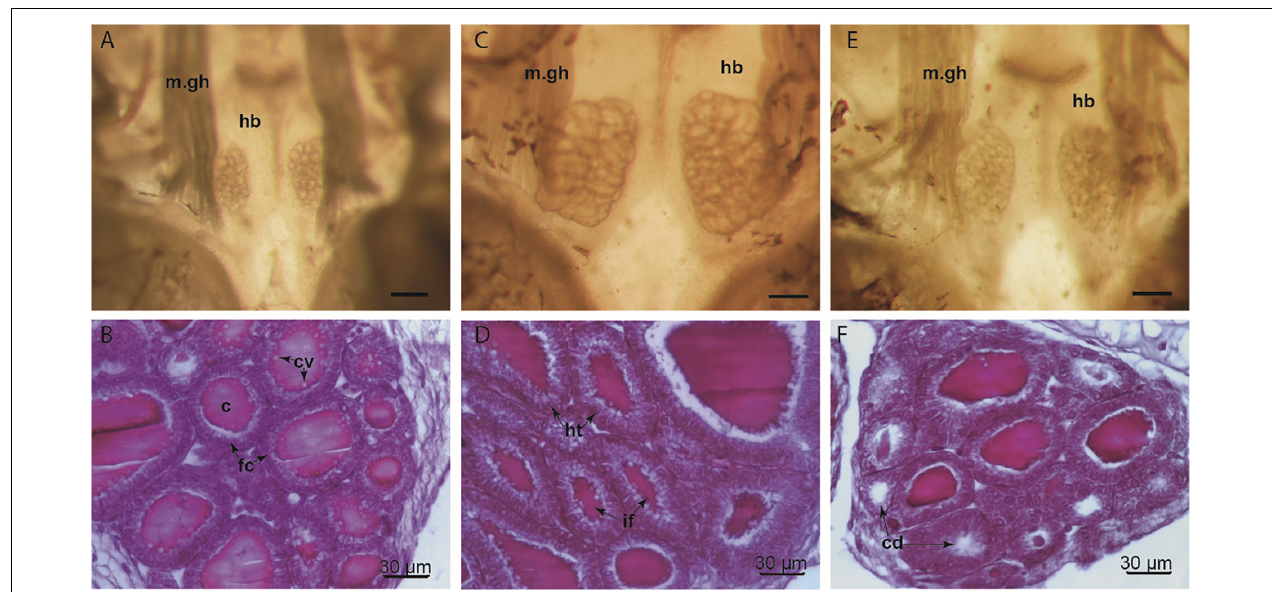
FIGURE 2 | Thyroid gland of Pleurodema borellii larvae (Gosner Stage 40, 31 days after hatching), macroscopic and microscopic images. (A,B) Control tadpoles showed the typical follicular morphology of the normal thyroid gland, with cuboidal follicular cells and follicular colloid. (C,D) Specimens from methimazole early exposure exhibited an overall glandular hypertrophy. The histology revealed an evident follicular cell hypertrophy and irregular follicular morphology. (E,F) Specimens from thyroxine early exposure have thyroid glands with follicular lumina less defined relative to the normal gland are also observed. Histological section shows slight depletion of colloid and decrease in the number of chromophobic vacuoles. c, colloid; cd, colloid depletion; cv, chromophobic vacuoles; fc, follicular cells; hb, hypobranchial cartilage; ht, hyperthrophied cells; if, irregular follicles; m.gh, muscle geniohyoideus. Scale bar for macroscopic images = 0.3